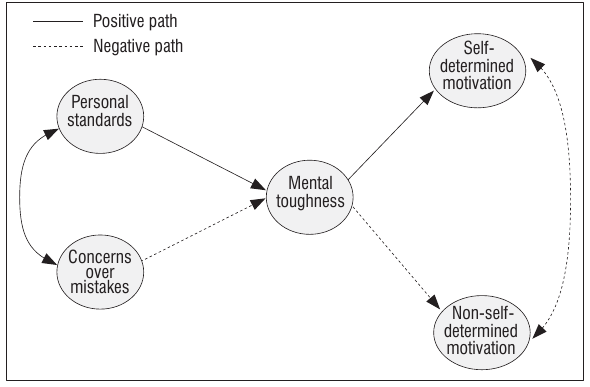
Hypothesised model of the relationships between dimensions of perfectionism, mental toughness and motivational